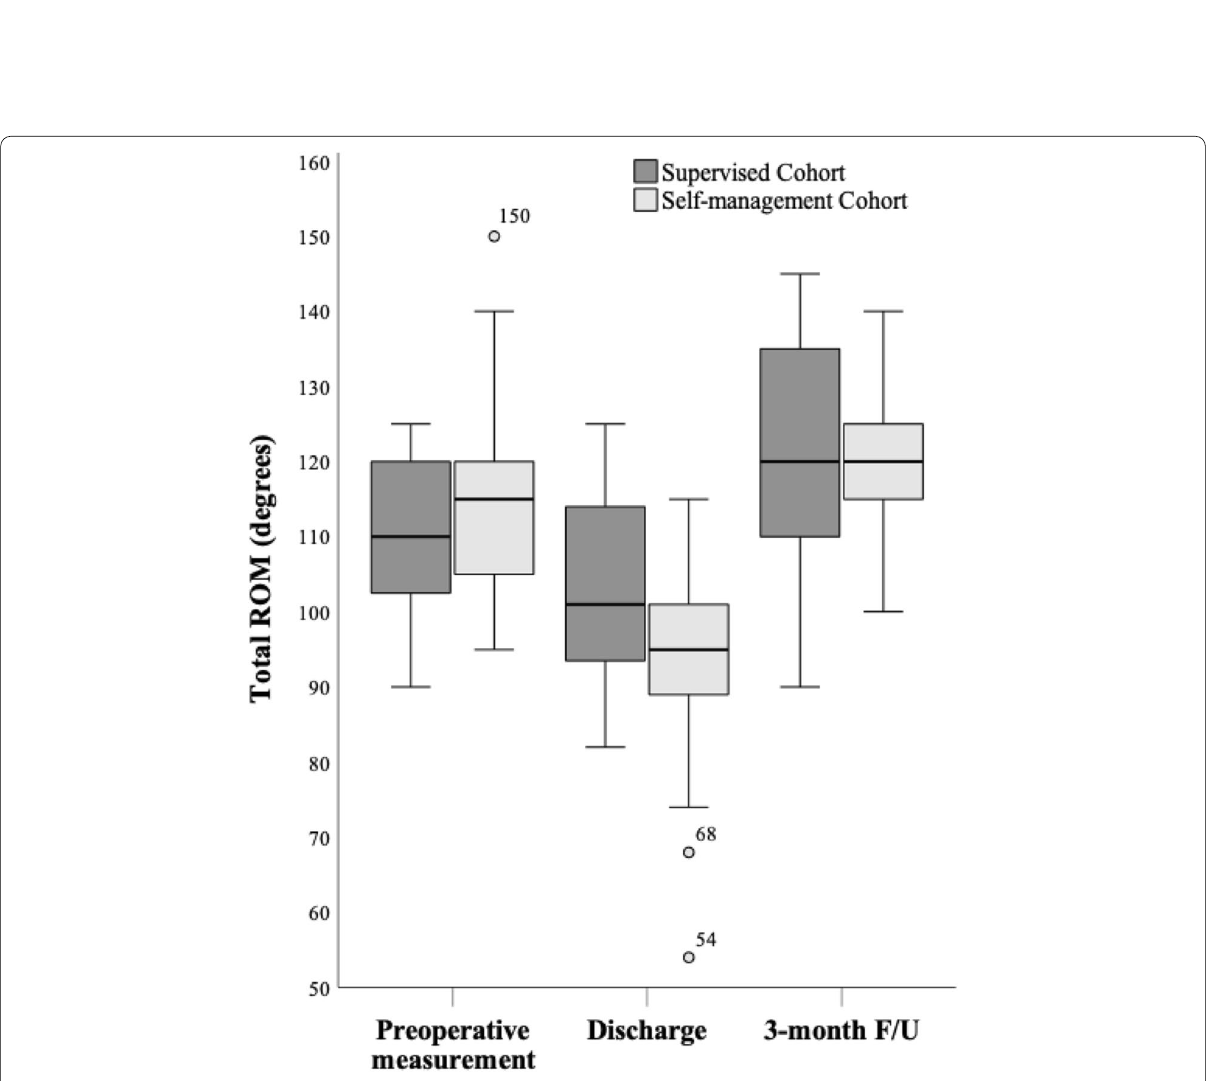
Fig. 4 Total ROM at preoperative, discharge and 3-month follow-up. The boxes represent the interquartile (IQ) range. Median indicated by line across the boxes. The whiskers are no greater than 1.5 times the IQ range. Outliers are cases with values between 1.5 and 3 times the IQ range depicted by circles and labeled with specific ROM measured in degrees. ROM: Range of motion; Pre-op: Preoperative; Post-op: Postoperative measured at discharge; F/U: